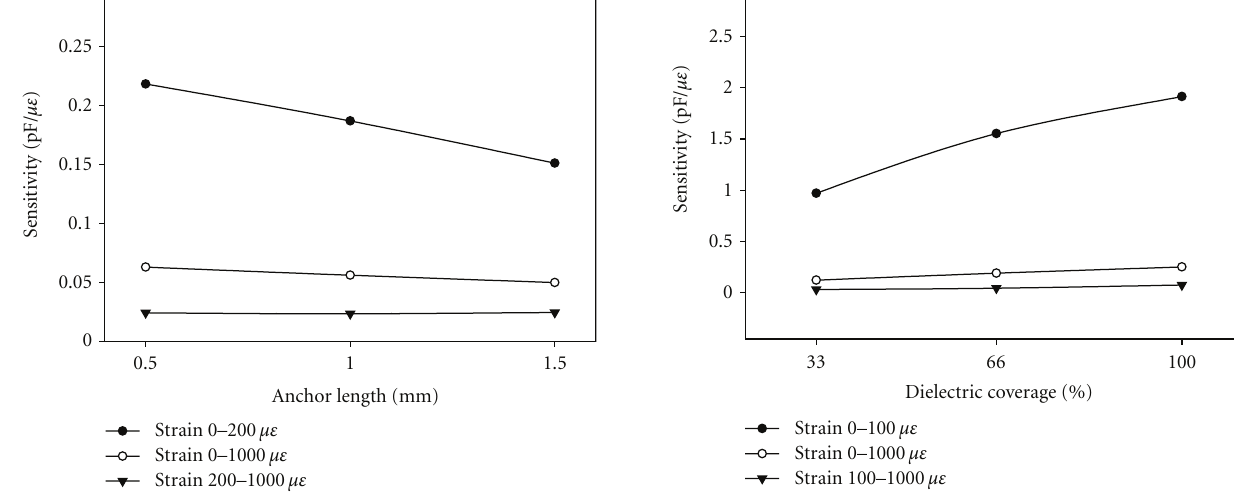
Figure 8: Sensitivity comparison for anchor length at di ff erent strain value.